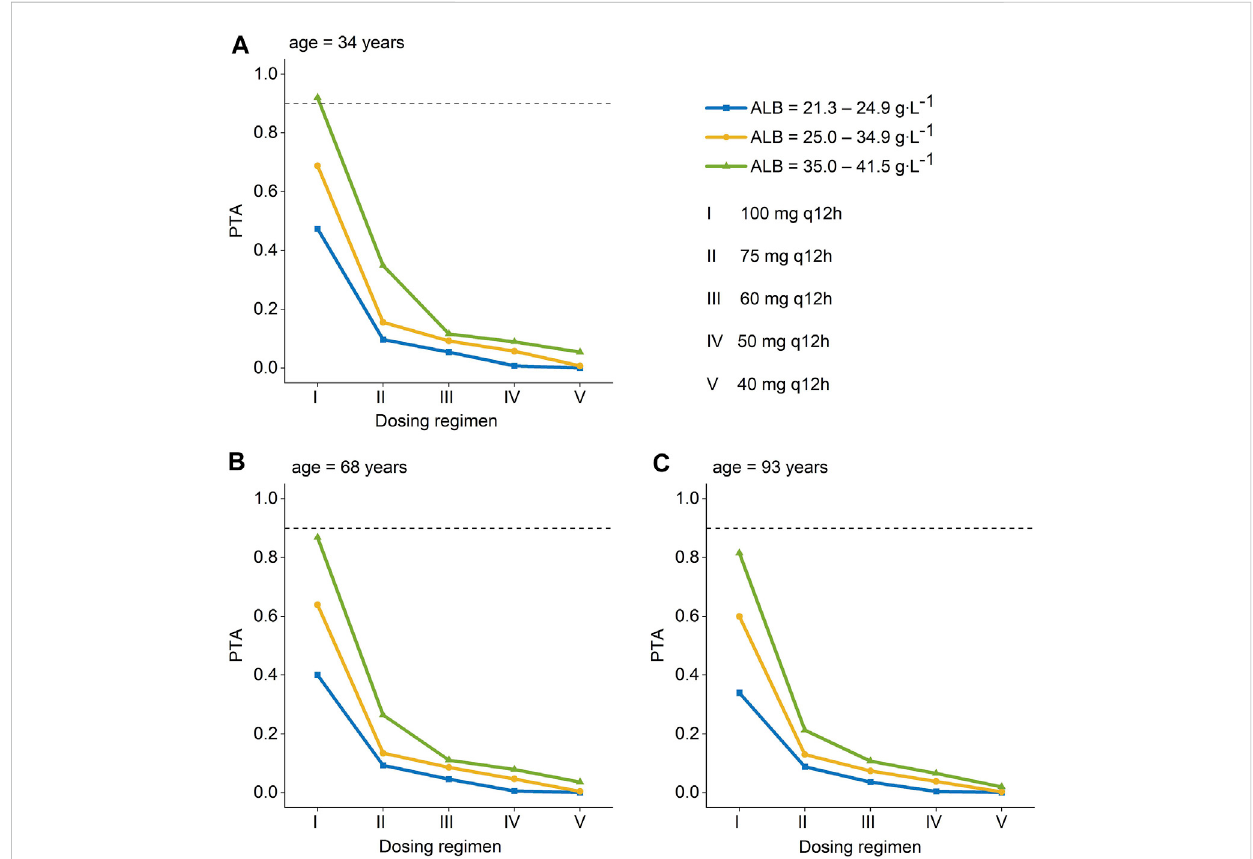
FIGURE 4 Probability of target attainment(PTA)for toxicity is de fi ned as an AUC ss,24h > 100 mg · h · L -1 for polymyxin B dosing regimens administered to patients. (A) age = 34 years; (B) age =68 years; (C) age = 93 years a . ( Ⅰ ): 100 mgq12 h; ( Ⅱ ): 75 mg q12 h; ( Ⅲ ): 60 mg q12 h; ( Ⅳ ):50 mg q12 h; ( Ⅴ ):40 mg q12 h. a The age were the patients ’ 5th, median, and 95th values. AUC ss, 24h , an area under the plasma – concentration-time curve across 24 h at steady